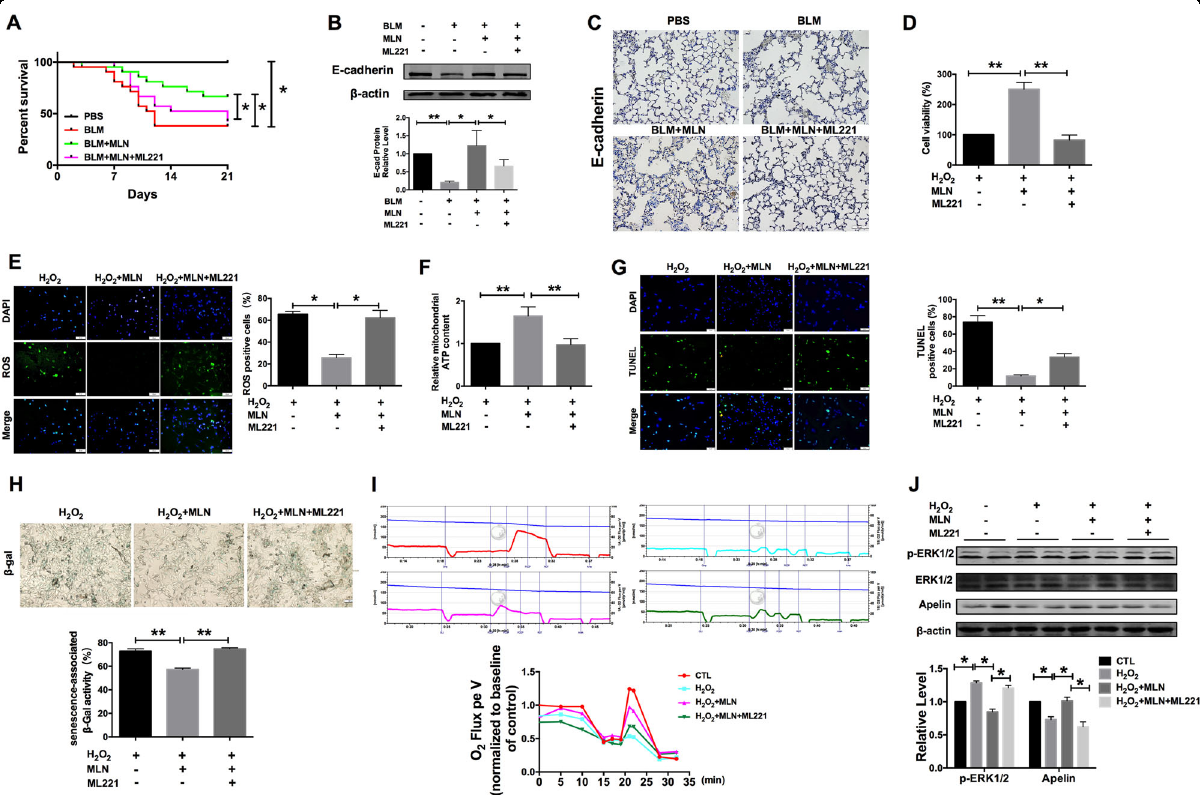
Fig. 6 Blocking Apelin 13 by ML221 inhibited the effect of melatonin on alveolar epithelial cells. a Survival curves of mice after the injection of PBS, BLM, BLM + MLN, or BLM + MLN + ML221. n = 21; * P < 0.05. b E-cadherin, a marker of alveolar epithelial cells, was assessed by immunoblot analysis. n = 4; * P < 0.05, ** P < 0.01. c The Immunohistochemical assay of E-cadherin in lung samples from mice in the PBS, BLM, BLM + MLN, and BLM + MLN + ML221 groups. Scale bar, 50 μ m. d The effect of ML221 on cell viability was determined using an MTT assay. n = 7; ** P < 0.01. e Comparison of ROS production in TC-1 cells exposed to ML221. Green, ROS; blue, DAPI. Scale bars, 50 μ m. * P < 0.05. f ATP content in TC-1 cells treated with H 2 O 2 , melatonin, or ML221. The ATP content was normalized to the corresponding protein concentration. n = 5; ** P < 0.01. g Treatment with ML221 inhibited the antiapoptotic effect of apelin 13. Green, TUNEL-positive TC-1 cells; blue, DAPI. Scale bars, 50 μ m. * P < 0.05, ** P < 0.01. h Left, TC-1 cells were treated with ML221 and were then fi xed and stained for senescence-associated β -gal activity. ** P < 0.01. i Representative pro fi les and summary data for oxygen consumption in TC-1 cells. The blue arrow indicates the oxygen concentration in the detection chamber. The blue line indicates the oxygen concentration in the detection chamber. j Western blot assays were performed to determine the protein levels of p-ERK1/2 and apelin 13 in TC-1 cells. n = 4; * P <